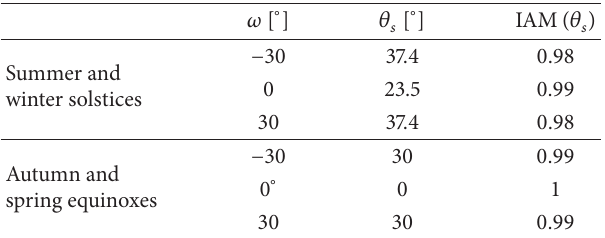
Table 2: Values of the incident angle modifier for solstices